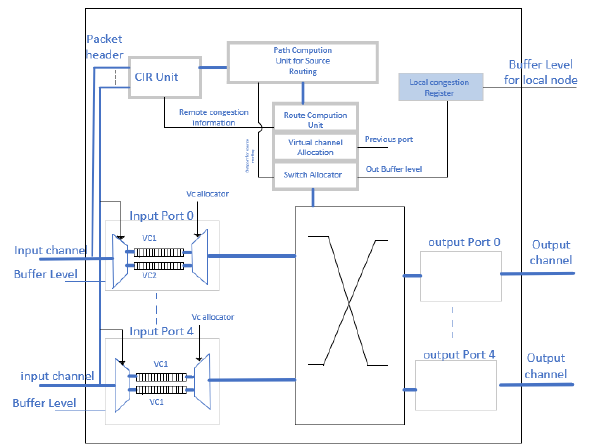
Fig. 6. Router Architecture to implement the proposed